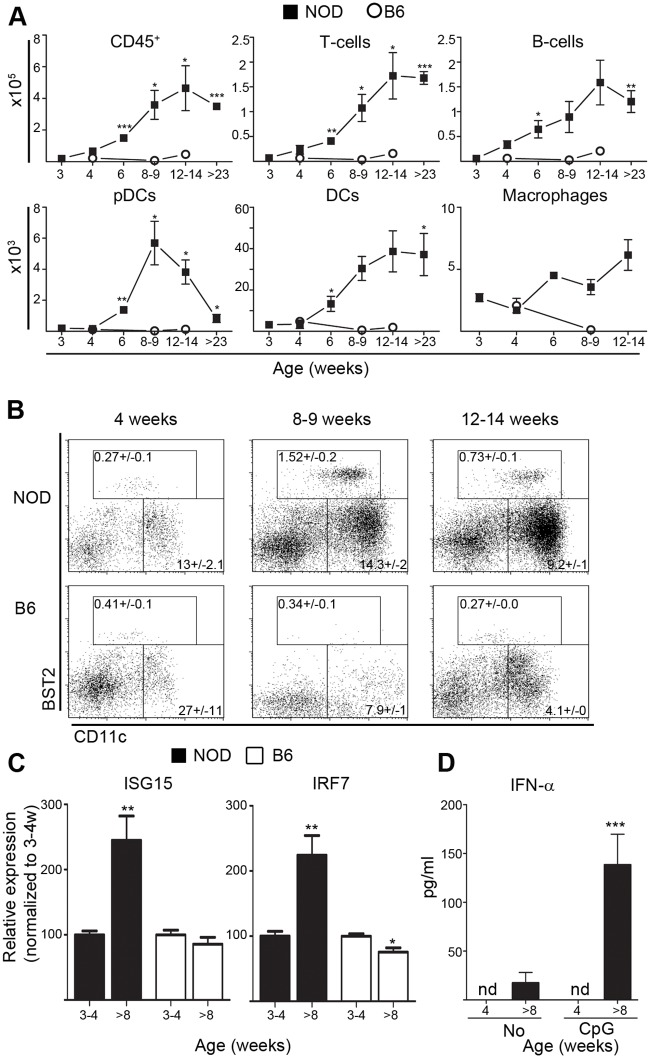
IFN-α-secreting pDCs peak in the pancreatic islets of NOD mice at 8–9 weeks.(A) Infiltrating leukocytes (FVD−CD45+) from pancreatic islets were analyzed by flow cytometry for total number per mouse of T-cells (CD3+B220−CD19−), B-cells (CD3−B220+CD19+), pDCs (CD3−CD19−BST2+CD11cintB220+), inflammatory DCs (CD3−CD19−BST2−CD11chiMHC-II+) and macrophages (CD3−CD19−F4/80+CD11b+MHC-II+) from 3 to >23 weeks of age in NOD and B6 mice (mean ± sem, n = 4–21 mice, 2–5 independent experiments). * p<0.05, ** p<0.005, *** p<0.0005 compared to 4-week-old B6. (B) Representative dot plots of FVD−CD45+CD3−CD19− islet cells with the percentage of pDC and inflammatory DC subsets of total CD45+ cells indicated (mean ± sem, n = 4–21 mice, 2–5 independent experiments). (C) Expression of interferon response genes IRF7 and ISG15 is assessed by qPCR of RNA from handpicked islets of NOD (black bars) or B6 (open bars) mice at 3 and >8 weeks (n = 6–11 mice, 3 independent experiments). * p<0.05, ** p<0.005. (D) IFN-α levels in supernatants from cultured NOD islets at 4–17 weeks of age after 40h ± TLR9 ligand CpG1585 is assessed by ELISA (mean ± sem, n = 6–23 mice, 6–9 independent experiments). nd = not detected. *** p<0.0005 compared to “No” stimulation at same age.